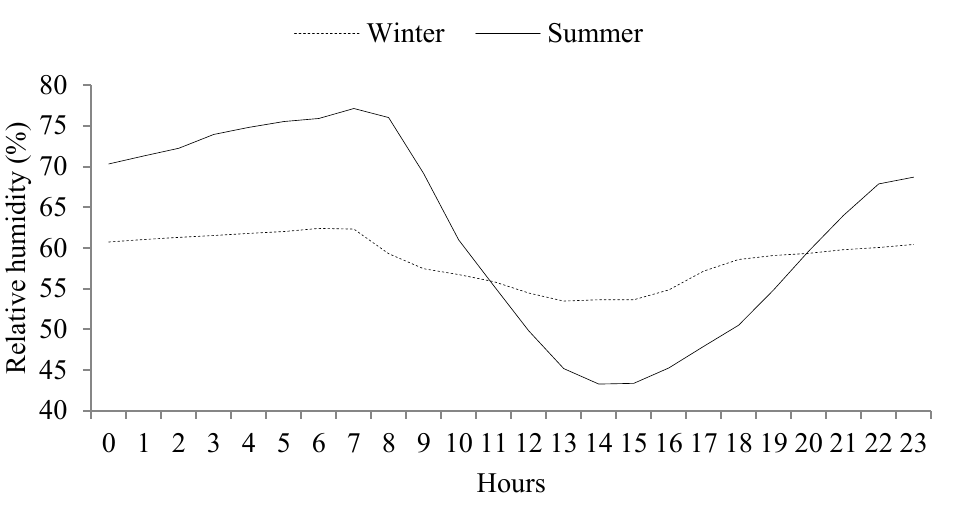
Figure 3. Relative humidity (%) regarding the time.